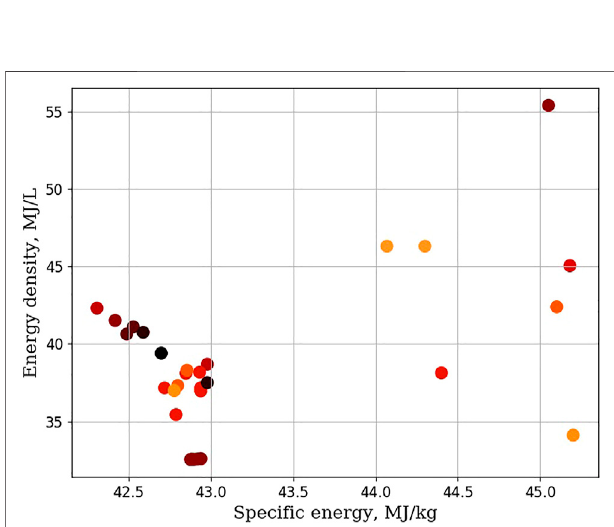
FIGURE 7 | SEED plot of the multicyclic cycloalkanes studied in this work. Speci fi c energy is in MJ/kg, Energy density is in MJ/L, and the shading of each marker corresponds to molecular weight. Darker colors indicate higher molecular